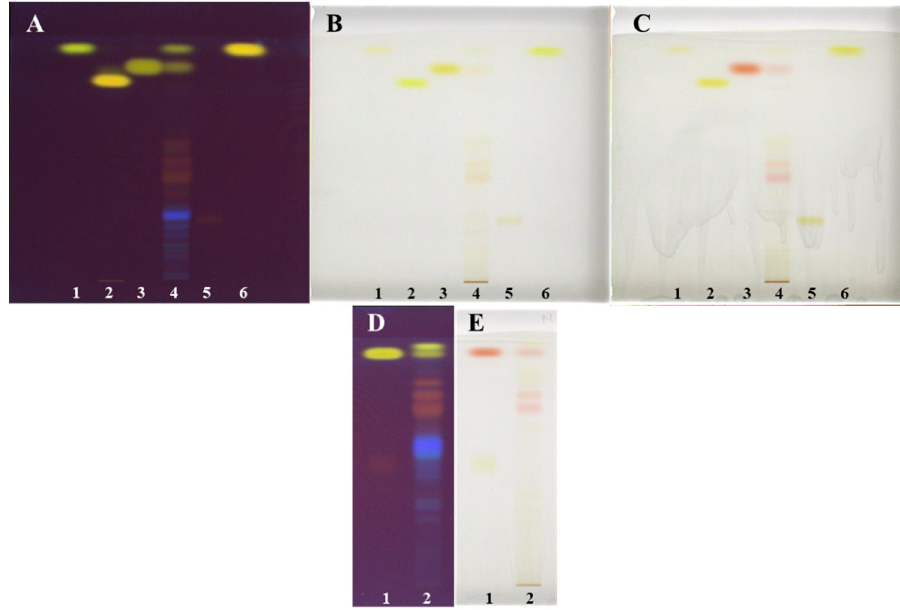
Figure 8. HPTLC chromatograms of standards and Japanese knotweed rhizomes STSs (2 μ L,